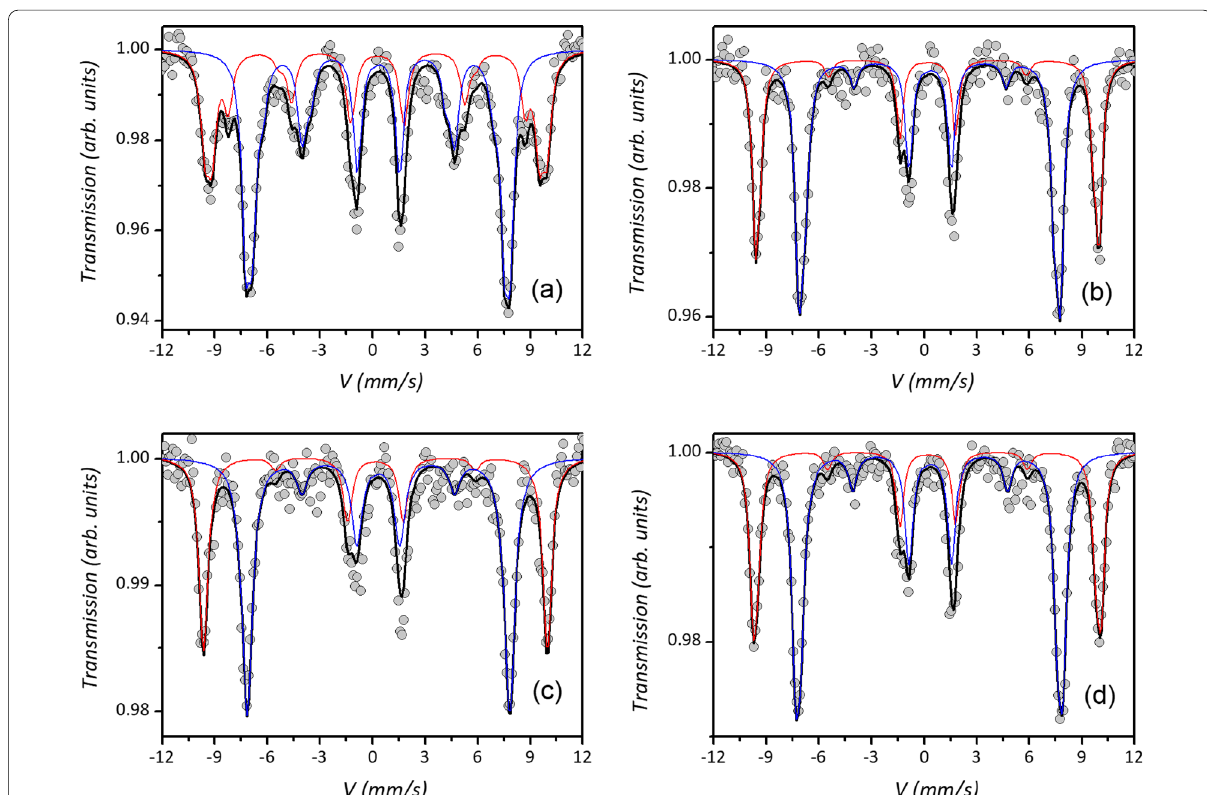
Fig. 5 Mössbauer spectra measured at 10 K under an applied field of 8 T for samples MAG1 ( a ), MAG2 ( b ), MAG3 ( c ), and MAG4 ( d ). A sum of two sextets, one for the tetrahedral (red line) and one for the octahedral (blue line) component of the spectra, have been fitted to the experimental data (circles). A black line describes the total fit to the experimental data (grey circles)